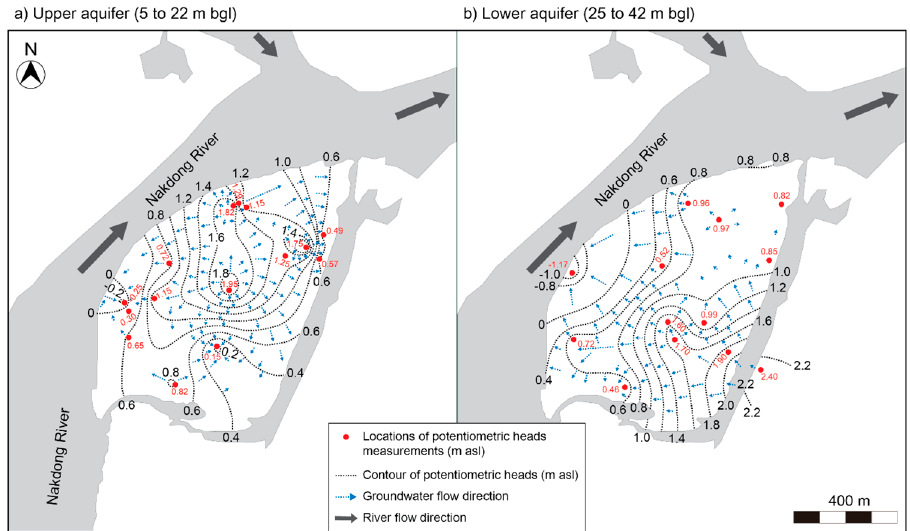
Figure 2. Locations of the measurements of potentiometric head levels, and the contours showing potential groundwater flow in the upper and lower aquifers in the study island. asl = above sea level, bgl = below ground level.